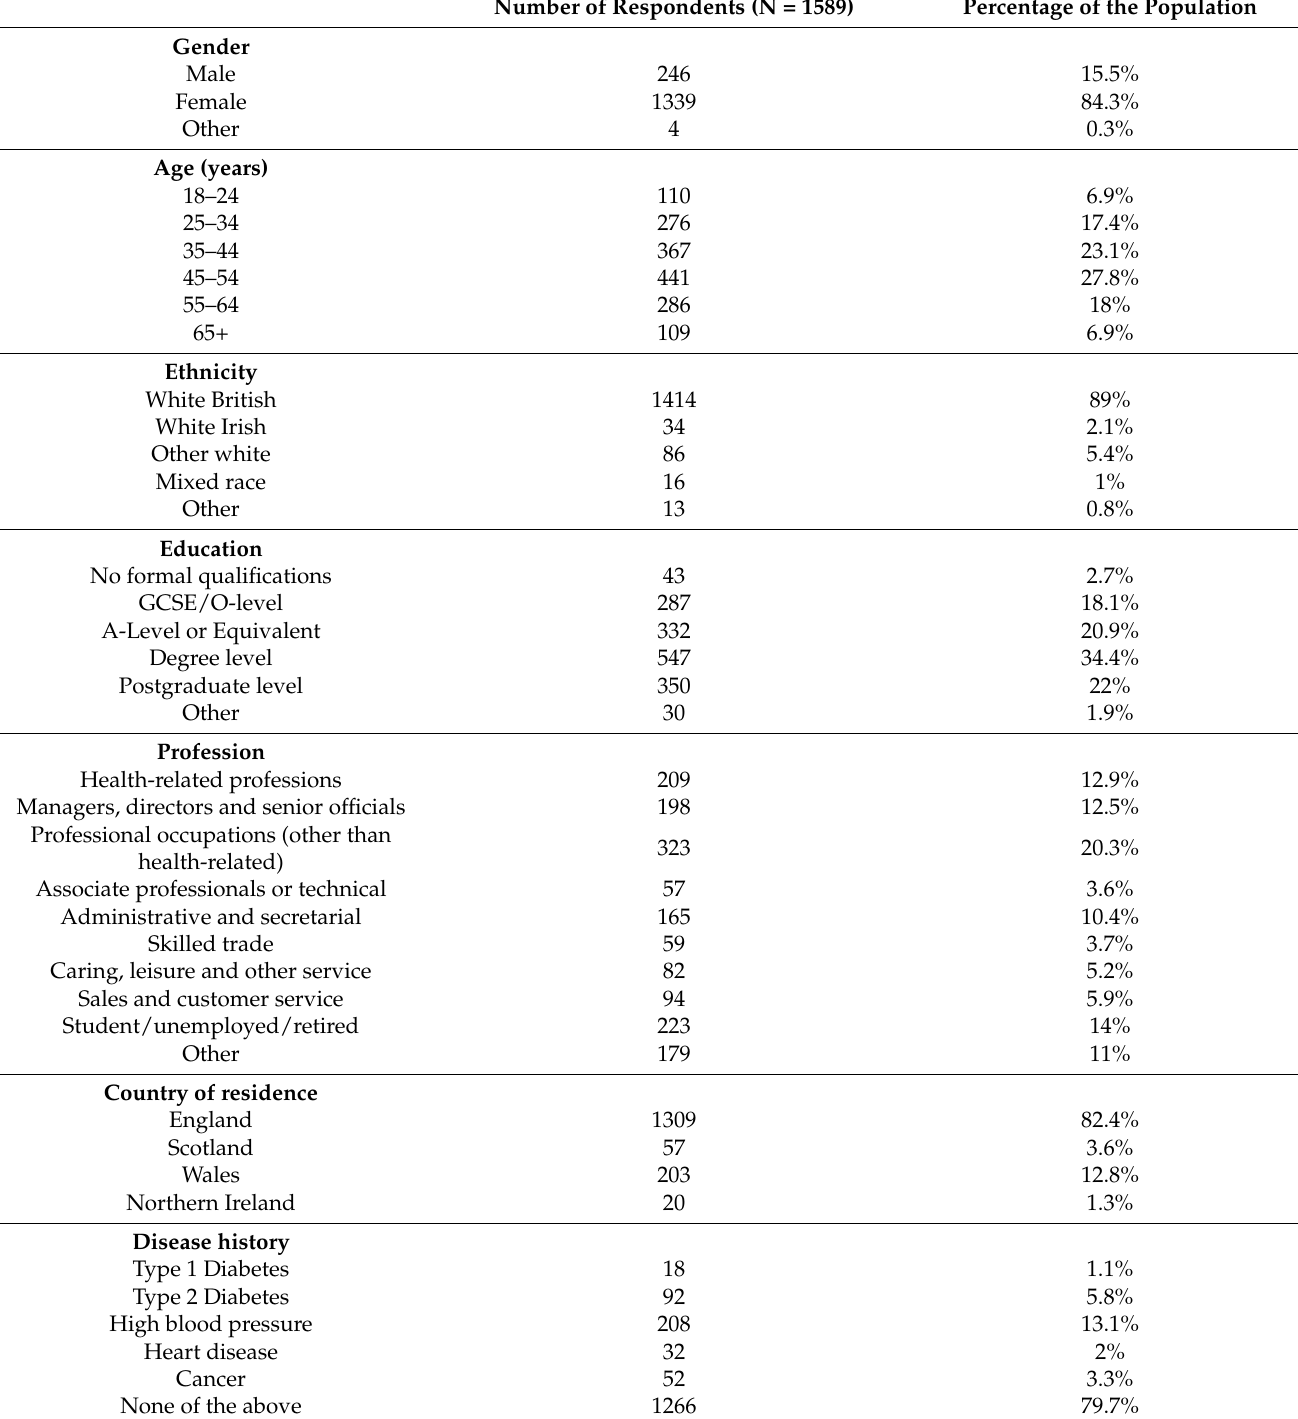
Table 1. Sociodemographic and health characteristics of the survey